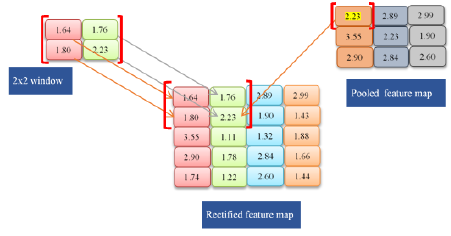
Figure 8. Applying maxpool operation.